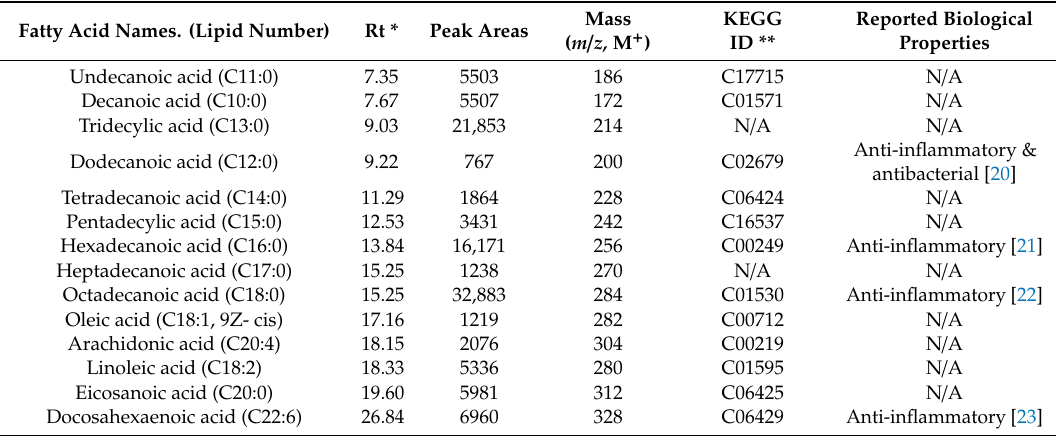
Table 2. Fatty acids identified from the ESP of D. caninum with their lipid number, mass, KEGG identities, and reported biological